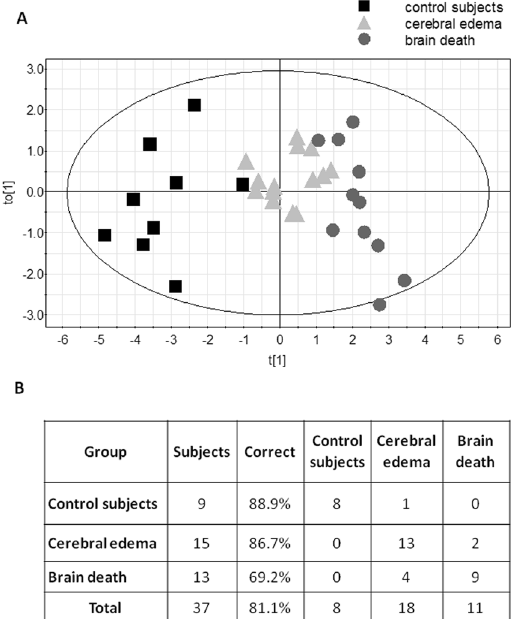
Figure 2. ( A ) Orthogonal partial least squares-discriminant analysis (OPLS-DA) scores plot of ICG inflow and outflow variables showing separation between the three groups. The control subjects are on the left side of scores plot, patients with posttraumatic cerebral edema are in the middle, and patients with brain death are on the right side of the scores plot (model 1). The score vector t o [1] represents within-group variation in the orthogonal component, while the score vector t[1] represents between-group variation in the predictive component. The group discrimination is seen along the t[1] axis. The ellipse represents Hotelling T 2 with 95% confidence in the scores plots. ( B ) Misclassification table of subjects classified to different study groups using model 1.